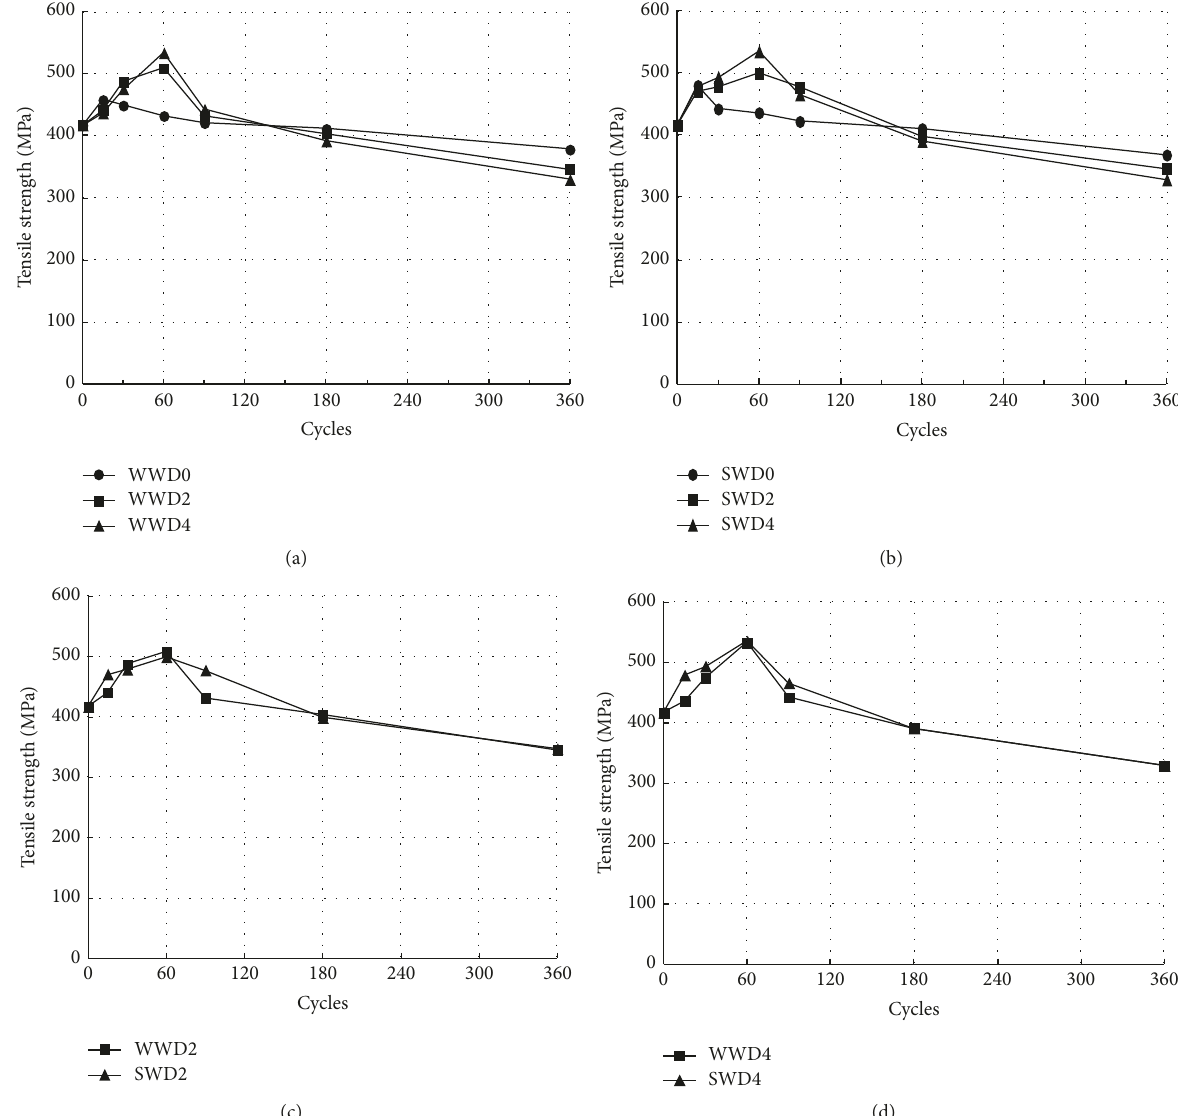
Figure 6: Tensile strength of stressed specimens (a) subjected to WD cycles of distilled water and different loads; (b) subjected to WD cycles of saltwater and different loads; (c) subjected to WD cycles and 20% ultimate tensile strength; (d) subjected to WD cycles and 40% ultimate tensile strength. Note. WWD2 and WWD4 are specimens exposed to WD cycles of distilled water and subjected to 20% and 40% ultimate tensile strength, respectively, and SWD2 and SWD4 are specimens exposed to WD cycles of saltwater and subjected to 20% and 40% ultimate tensile strength,